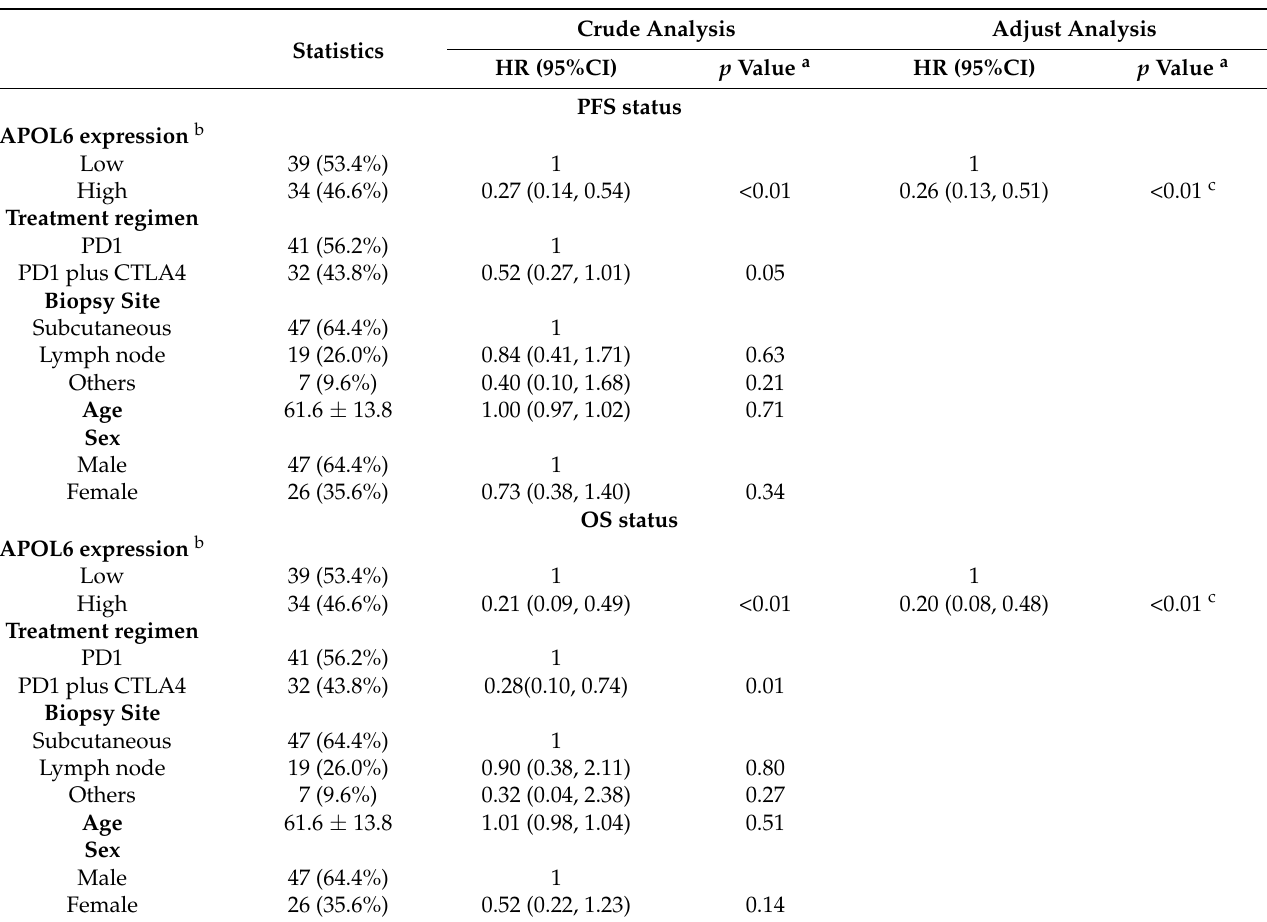
Table 3. Univariate and multivariate analyses of factors associated with patient survival in the melanoma cohort receiving